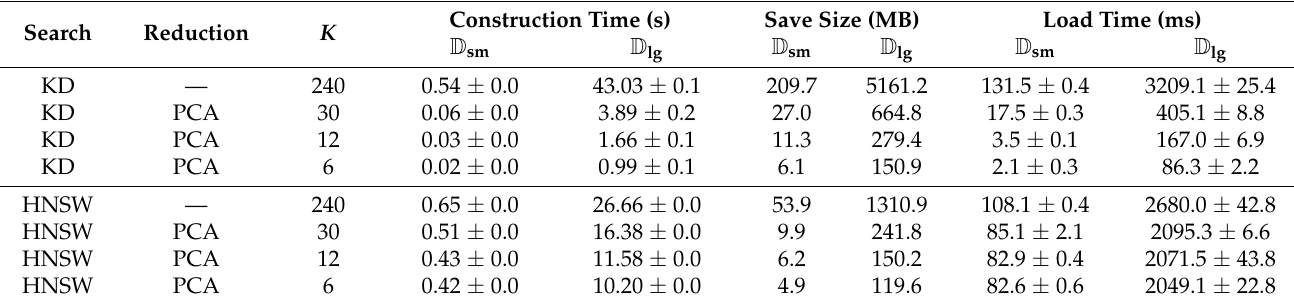
Table 5. Performance measures for constructing, saving, and loading the index structure.